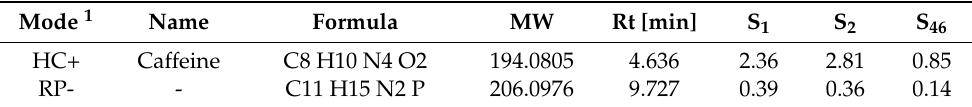
Table 1. Examples of two hits obtained with UHPLC–HRMS and the information available for each of